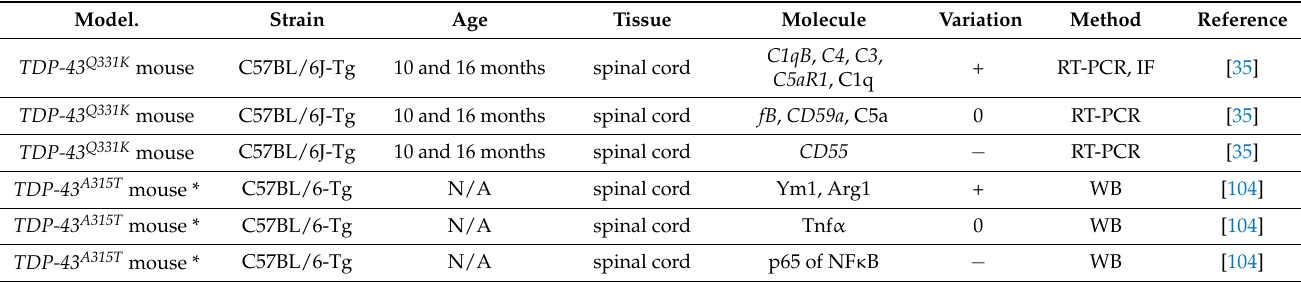
Table 4. Microglial alterations in TDP-43 animal models based on the age, collected tissue and method.